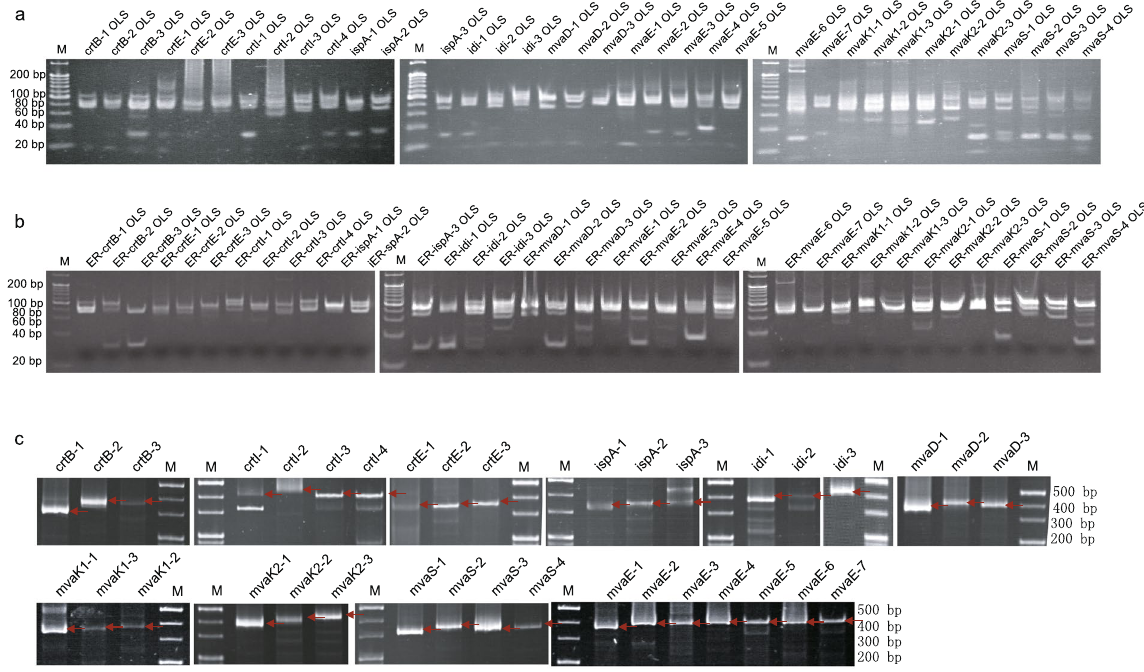
Figure 3. Low-throughput synthesis of gene fragments. ( a ) Selective amplification of each subpool for generation of lycopene biosynthetic genes. Subpools were directly amplified using the oligo pool cleaved from the microchip as the template. ( b ) PCR of each error-depleted subpool. The oligo subpool was amplified with the error-depleted elute from etMICC as the template. ( c ) Fragments assembled by LCR from error-depleted oligo subpools. M, 20 bp DNA ladder (TaKaRa Bio). Red arrows indicate target fragments. OLS, oligo subpool; ER,